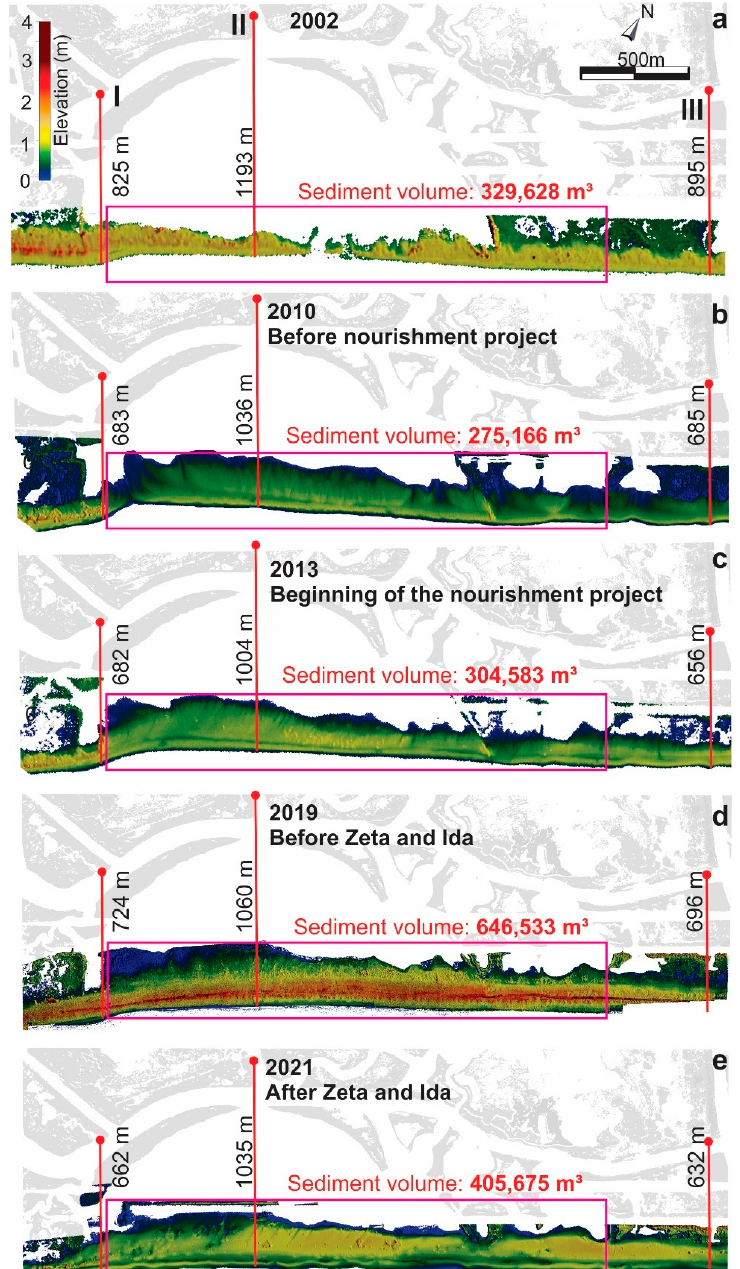
Figure 6. Spatial-temporal analysis of the beach barrier dynamics based on satellite and drone images between 2002 and 2021 ( a – e ). The purple boxes mark the areas used as references for sediment volume calculation. The red dots mark the three fixed reference points that were used to calculate the shoreline dynamics at planialtimetric cross-shore profiles I, II, and III. The three red lines in each figure mark the distance between the fixed reference points and the seaward edge of the beach barrier at the low